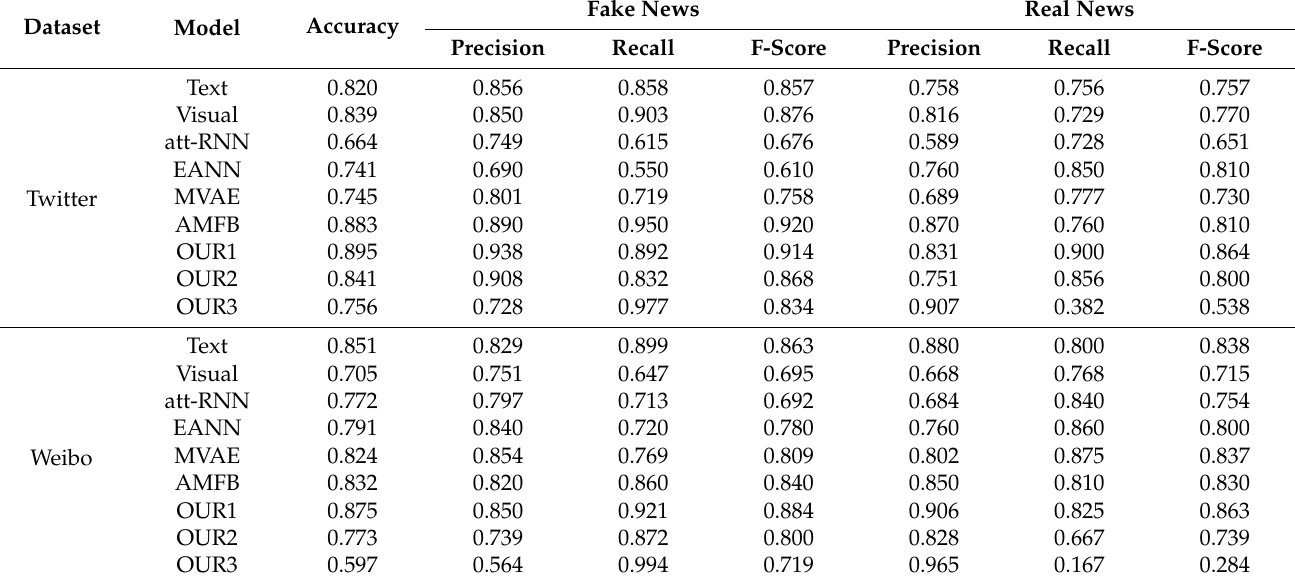
Table 5. Experimental results on two